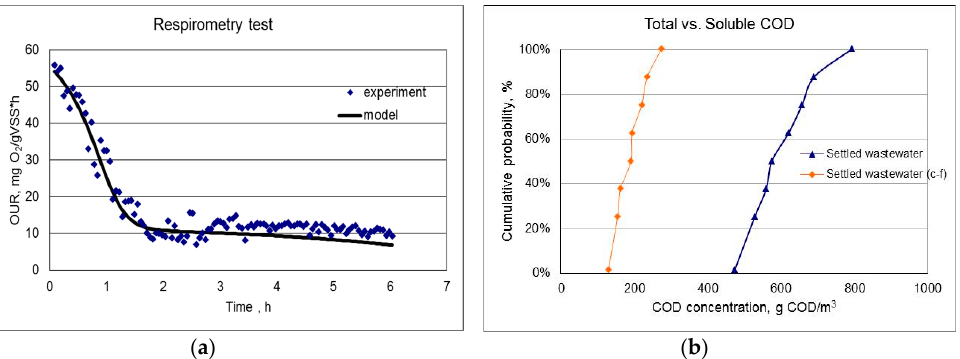
Figure 4. Exemplary results of the respirometry test and COD measurements during the summer study period, T = 20 °C from Gda ń sk WWTP: ( a ) OUR behavior vs. model prediction with the settled wastewater and biomass ( b ) total vs. soluble COD with the settled wastewater and after coagulation-flocculation (c-f)